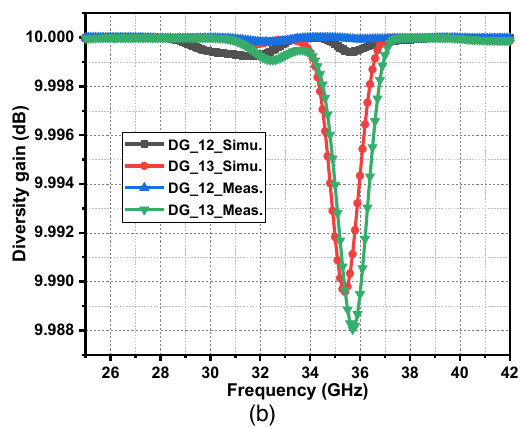
(b) FIGURE 12. The proposed MIMO antenna (a) ECC and (b) DG. 2) MEG AND EDG MEG is the ratio of the accepted mean power to the average incident power by the antenna in comparison to the isotropic antenna. It can be calculated using the relation given in [45].The simulated and measured results are shown in Fig. 13.It can be seen that the antennas possess good values of MEG in the range from -0.4 dB to 0.4 dB.